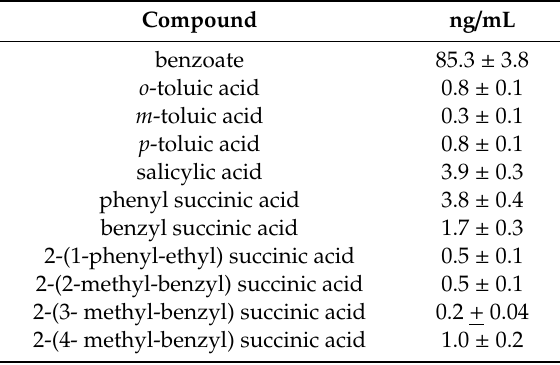
Table 3. Concentrations of BTEX Metabolites Found in the Ground Water Sample from Deep Gas Storage